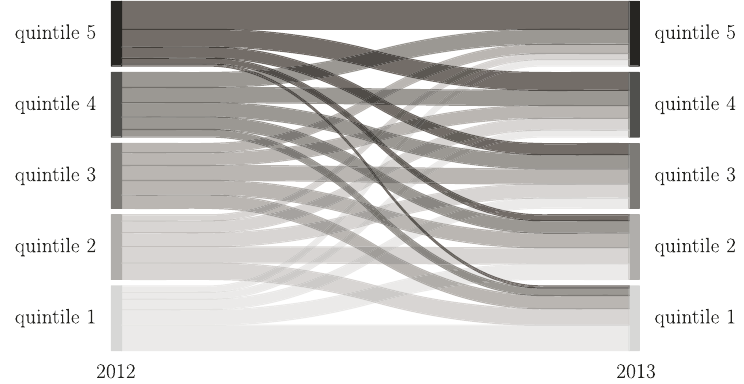
Figure 1: Flow of hospitals between quintiles of TPS in 2012 – 2013.